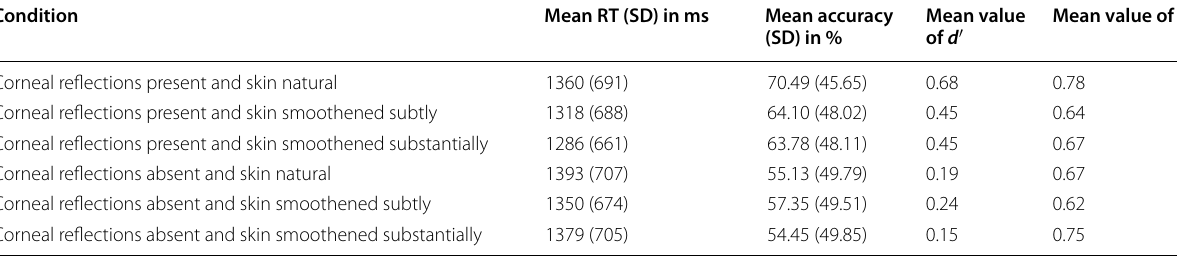
Table 1 Response times, accuracy, sensitivity index d ′ and response bias c across different conditions